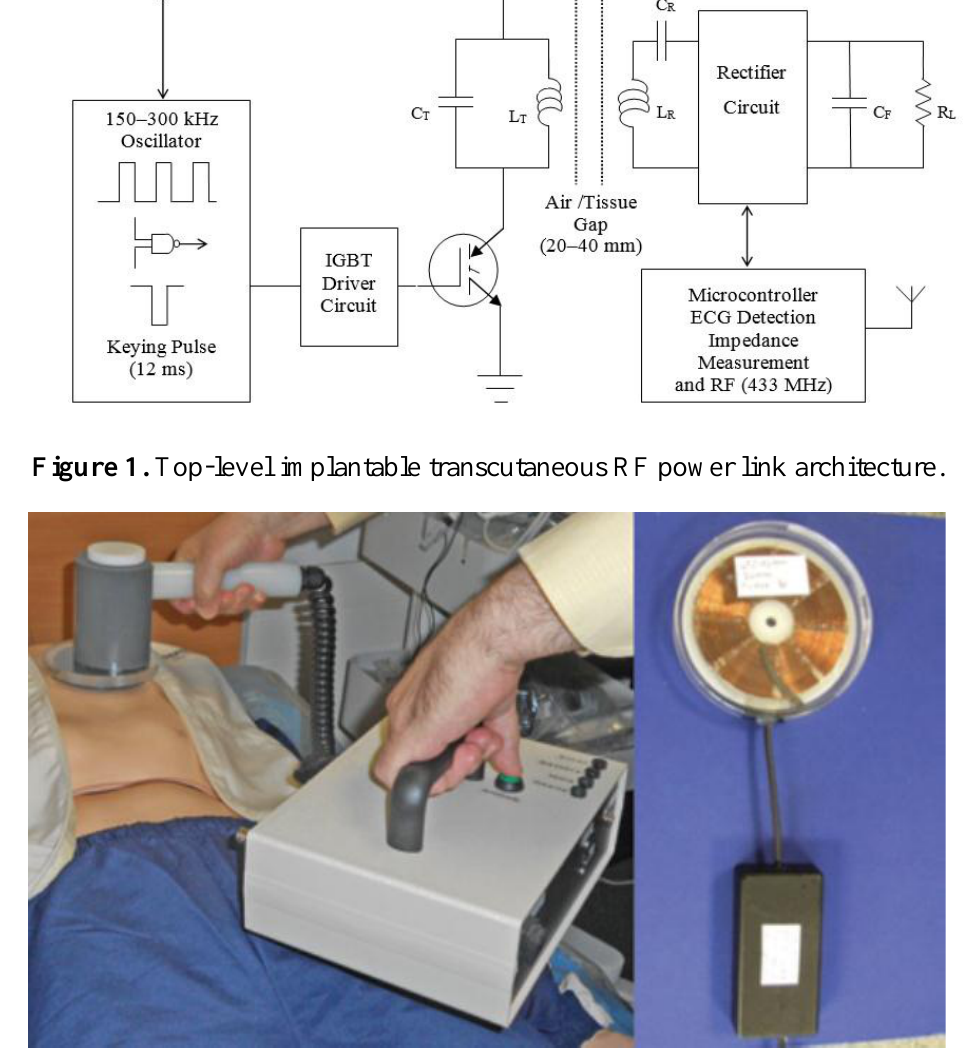
Figure 2. Prototype hand-held ( ex vivo ) radio frequency (RF) power-transmitter and prototype battery-free implantable ( in vivo ) power-receiver (encapsulated for bench